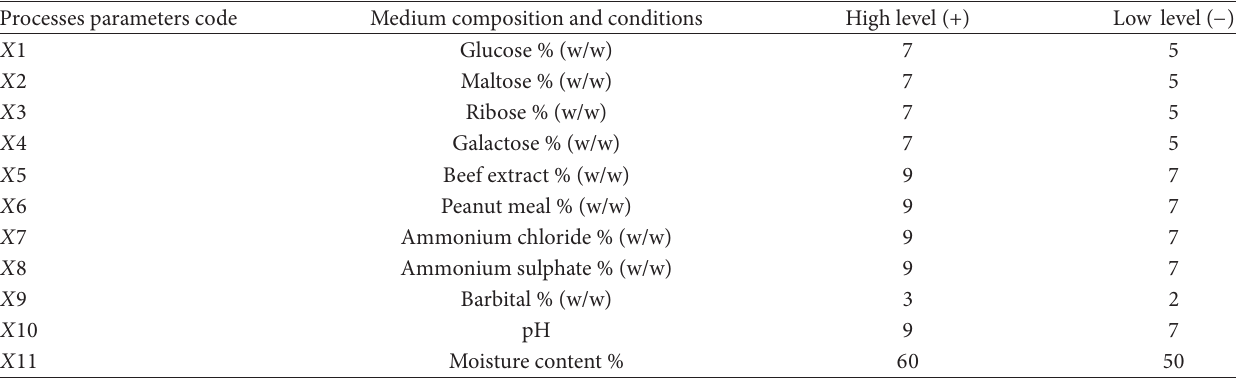
Table 1: Level of the production parameters for production of rifamycin B from Nocardia mediterranei MTCC 14 by using Plackett-Burman design test.